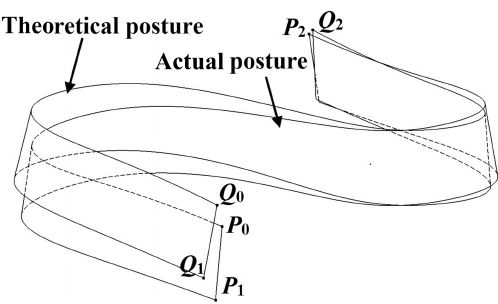
Figure 5. The initial posture of the